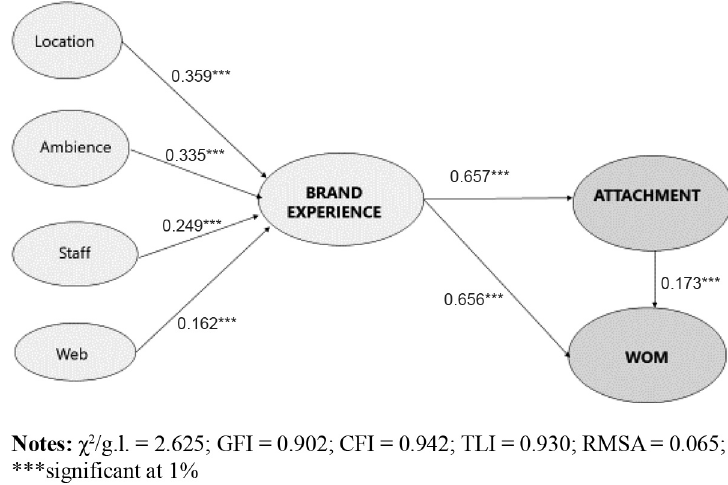
Figure 2. Structural model: antecedents and consequences of brand